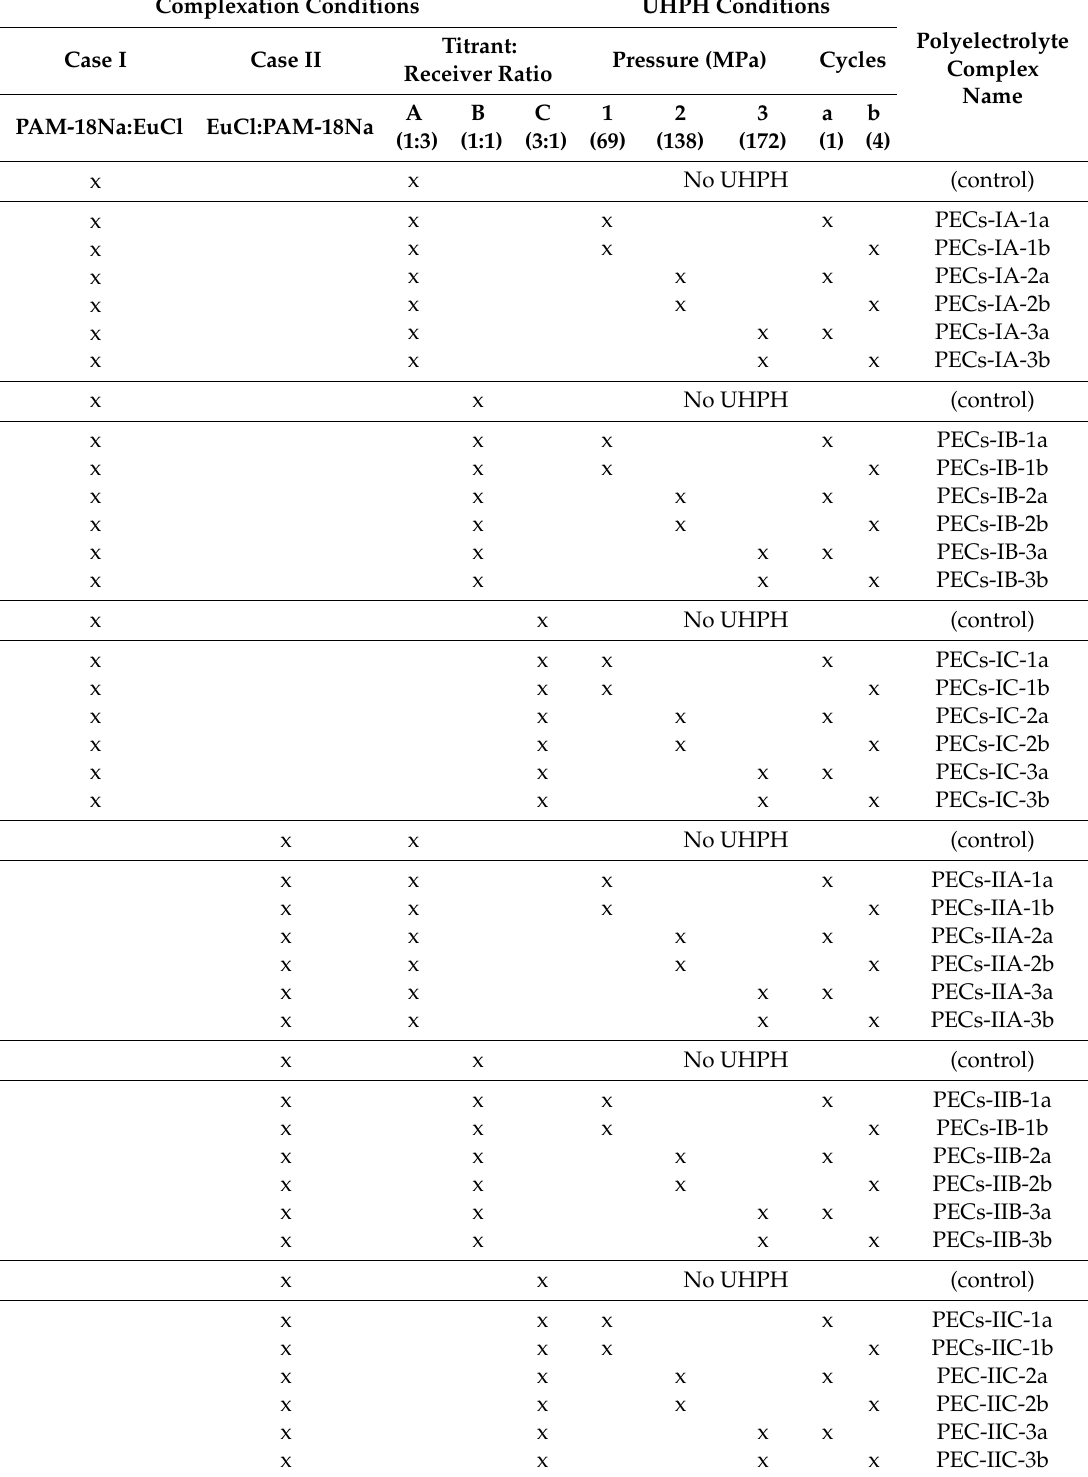
Table 1. Experimental conditions employed in the development of polyelectrolyte complexes. Complexation Conditions UHPH Conditions